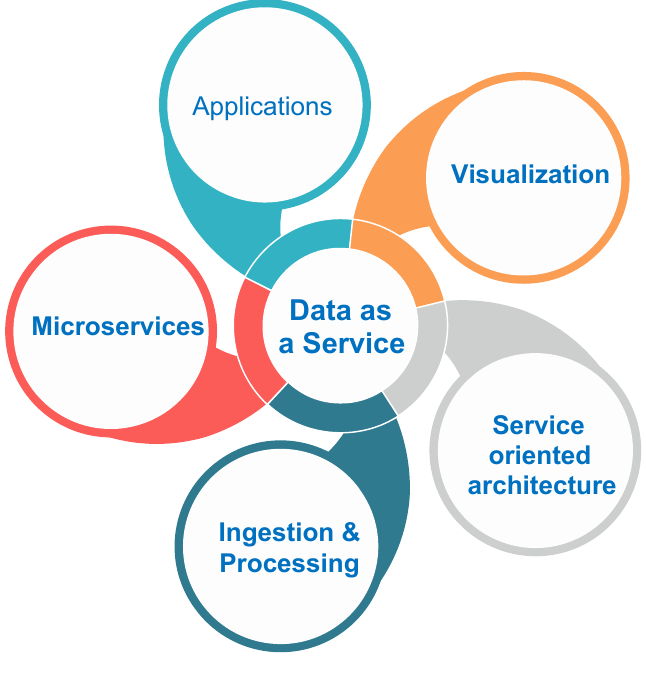
Figure 2. Data as a